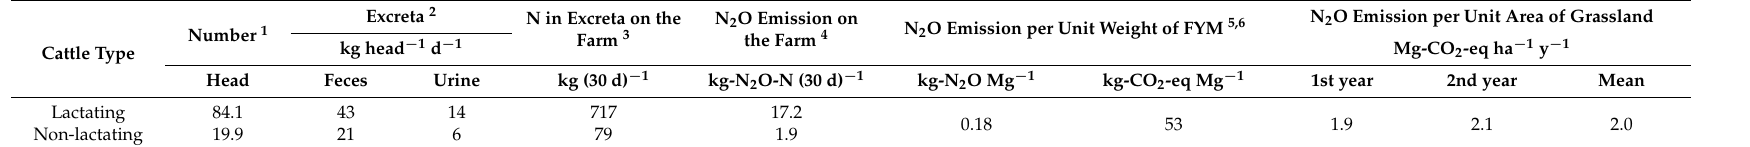
Table 3. Emission of N 2 O related to composting dairy